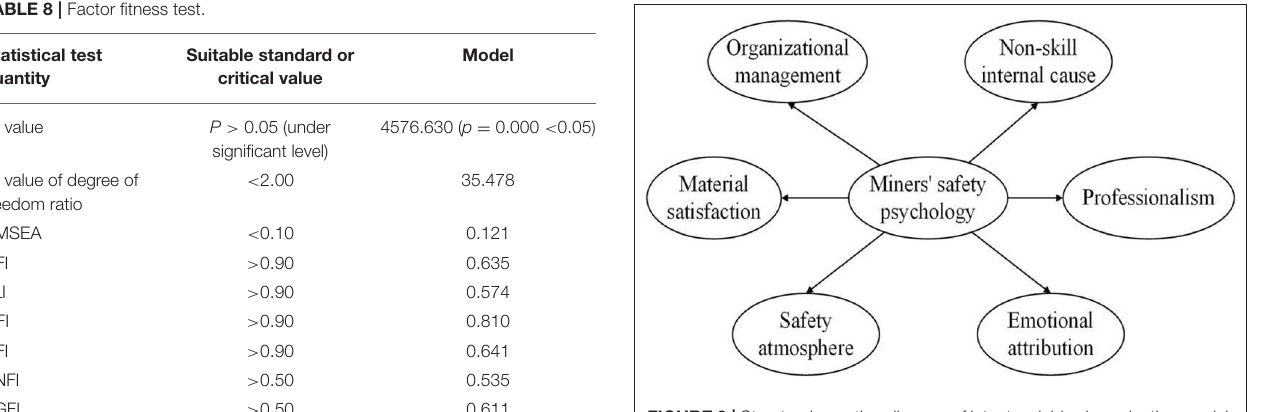
FIGURE 3 | Structural equation diagram of latent variables in evaluation model.